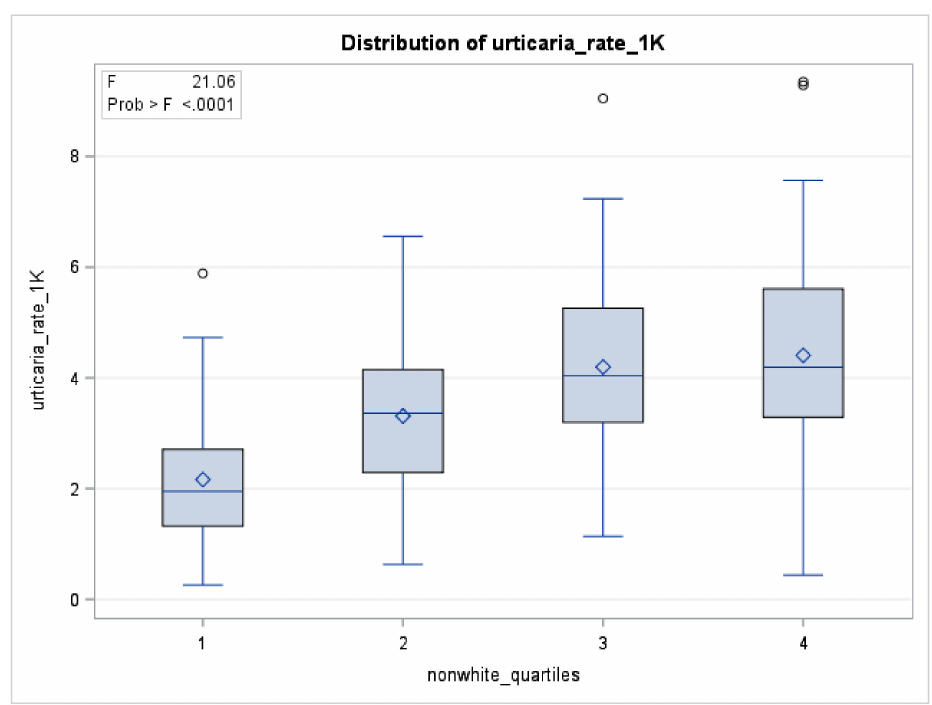
Figure 2. Distribution of acute urticaria rate per 1000 residents by percent of non-white residents’ quartiles for selected zip-codes ( n = 201), San Joaquin Valley, 2016–2017. Boxplots for percentage of non-white quartiles 1–4 are shown (F <